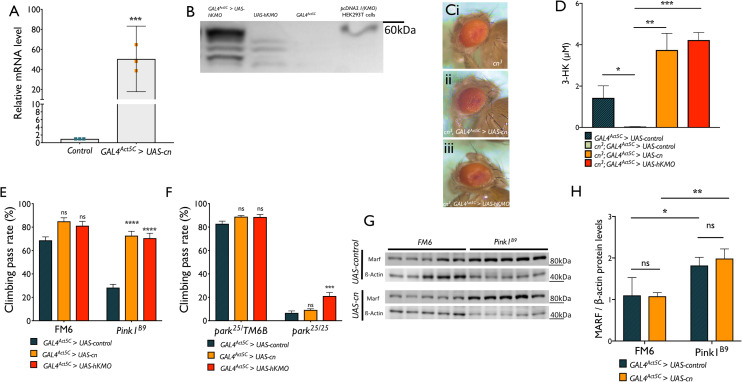
cn or hKMO overexpression rescues climbing ability in Pink1B9 and park25 flies while not affecting Marf levels.(A) Overexpression of UAS-cn was driven by GAL4Act5C. Expression of cn was assessed by qPCR of cDNA from whole flies (mean ± SD, randomisation test, *** P < 0.0001). (B) Overexpression of UAS-hKMO was driven by GAL4Act5C. Expression of hKMO was assessed by SDS-PAGE and immunoblotting of 20 μg whole fly protein extract and ran alongside protein from HEK 293T cells transiently transfected with pcDNA3.1(KMO). (C)
GAL4Act5C
–driven overexpression of UAS-cn or UAS-hKMO is sufficient to rescue the eye colour phenotype in cn3 mutant flies. (D) 3-HK levels in heads from control flies, cn3, or cn3 overexpressing cn or hKMO constructs (mean ± SD, one way ANOVA, Tukey post hoc, * P < 0.05, ** P < 0.001, *** P < 0.0001, n = 5). (E, F)
cn or hKMO expression rescues Pink1 and parkin climbing phenotypes (mean ± SEM; two-way ANOVA, Tukey post hoc, *** P < 0.001, **** P < 0.0001, ns = not significant, 10 flies per n, n = 8–10). (G) Marf levels are not affected by cn overexpression. (H) β-actin normalised Marf levels are increased in Pink1B9 flies compared to FM6 (Pink1+) but unchanged by cn overexpression (Mean ± SD, two-way ANOVA, Tukey post hoc, * P < 0.05, ** P < 0.01, ns = not significant, n = 5).